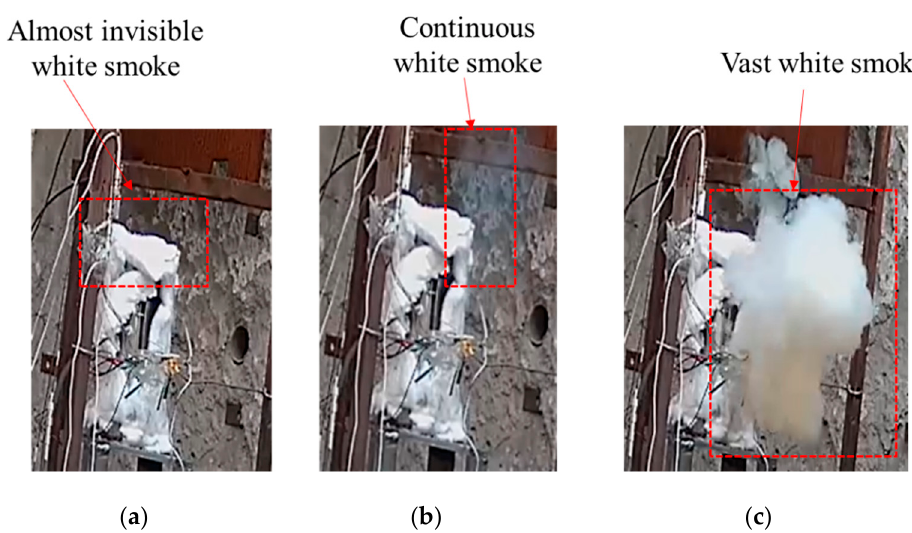
Figure 7. Response of cook-off bomb of shot 1. ( a ) Initial ignition. ( b ) Secondary jump. ( c ) Third jump.